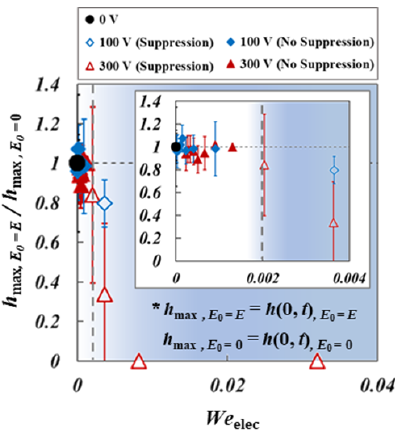
Figure 6. Effects of electric field strength on the suppression of dimple formation. Nondimension- alized film heights based on the electric Weber number ( 𝑊𝑒 elec ) for an electrified ethanol droplet.